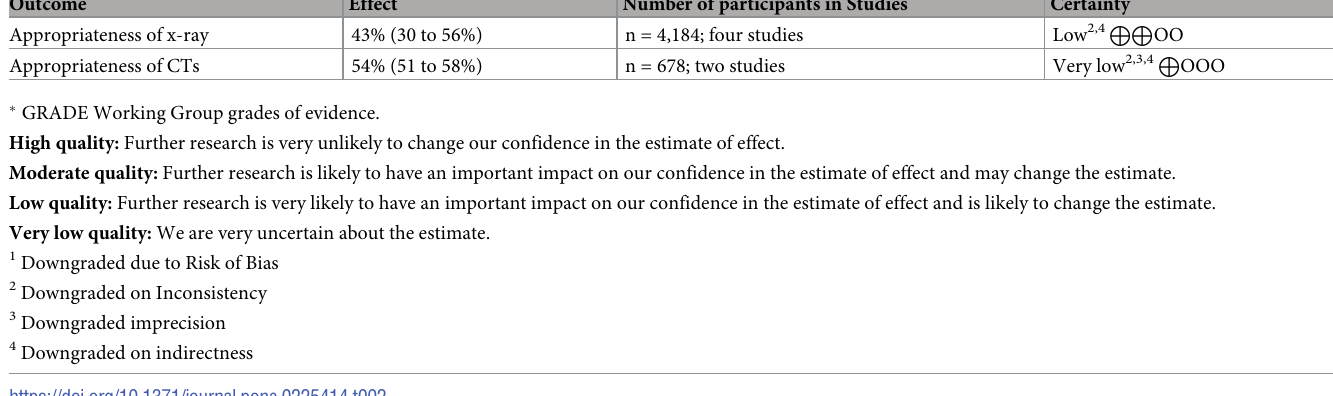
Table 2. GRADE summary of findings for the outcome of appropriateness of x-ray and CT imaging for patients with low back pain. Appropriateness of x-ray and CT imaging in patients with LBP ordered by primary and emergency care physicians Population: Patients with any type of low back pain Setting: Emergency department, General Practice, Hospital Comparison: Back pain guidelines for imaging, assumed to focus on red flag indicators Outcome Effect Number of participants in Studies Certainty Appropriateness of x-ray Appropriateness of CTs